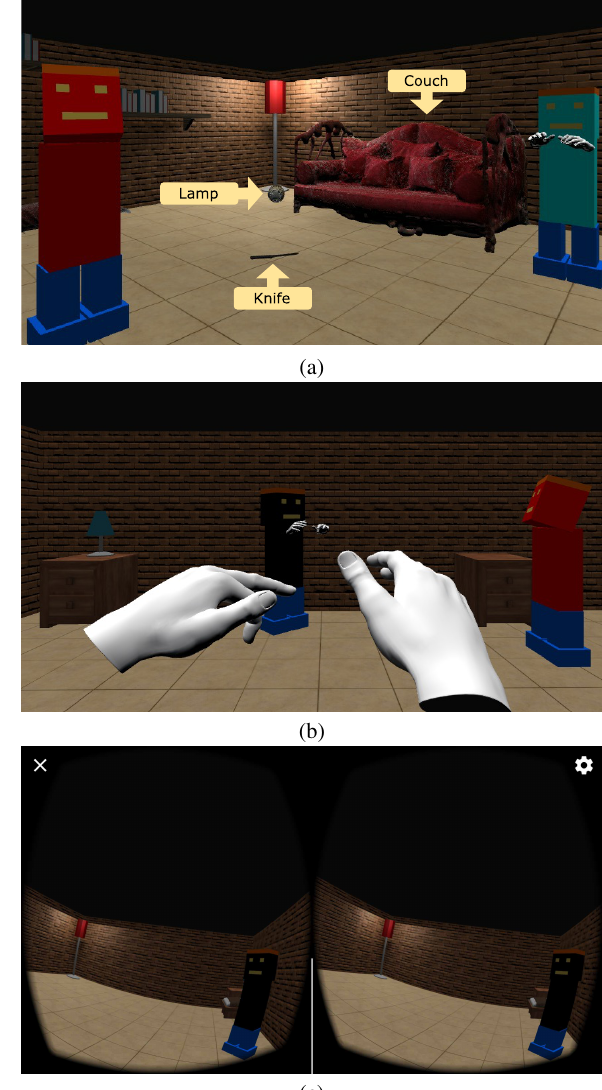
Figure 7. Collaborative virtual environment associated to a foren- sic use-case. (a) The VR environment includes a reconstructed couch, a reconstructed lamp and a knife. The lamp and the knife have been positioned lying on the floor to simulate a crime